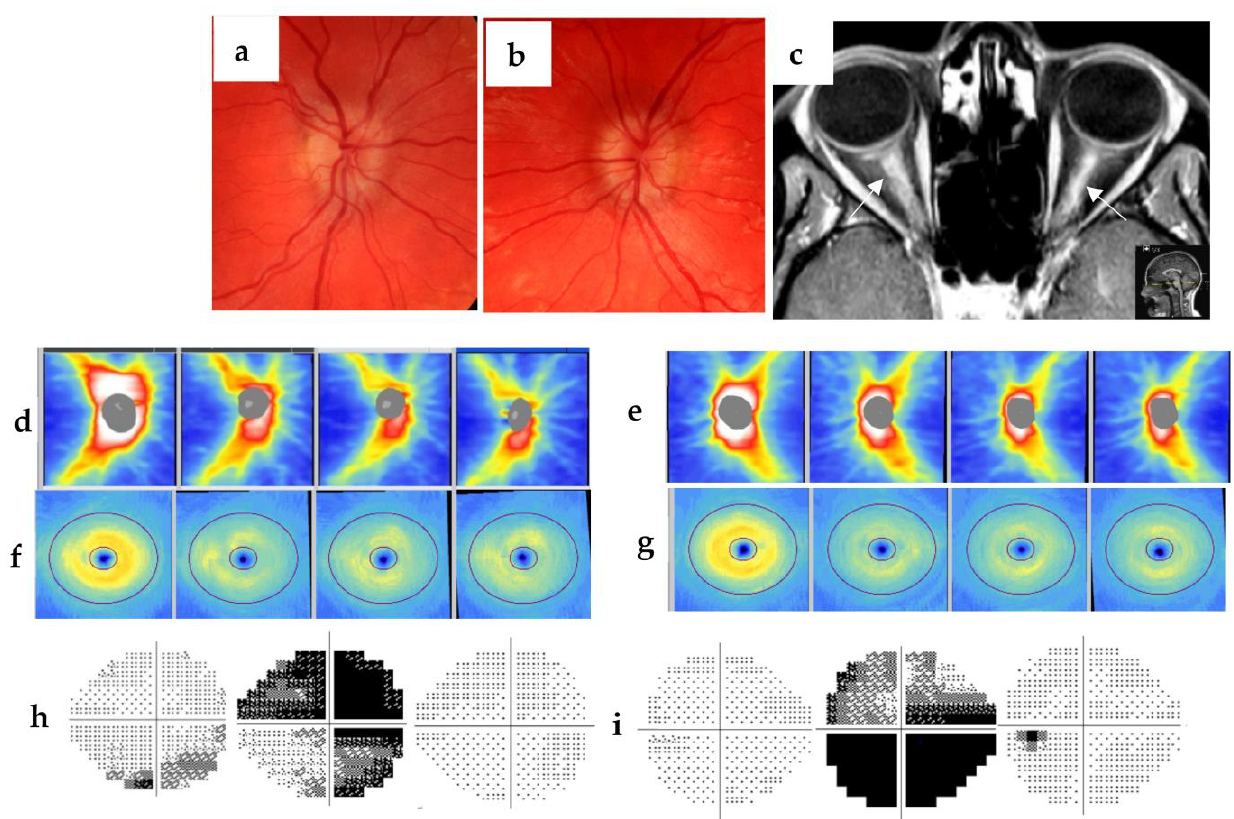
Figure 3. A 23-year-old obese female with positive myelin oligodendrocyte glycoprotein (MOG) antibody had bilateral subclinical ON demonstrated with MRI, OCT and VF. Fundoscopy showed papilledema in both right ( a ) and left eye ( b ). Orbital MRI visualized pathologic enhancement in the intraorbital optic nerves bilaterally ( c ). OCT thickness map showed significantly thickened RNFL in both right (152 µm) ( d ) and left (126 µm) ( e ) eyes at day 7, which was thinned at week 6 (right 100 µm, left 92 µm) and stable at follow-up of 3. 5 months and 3 years after onset. At day 7, GCIPL thickness was normal (right 74 µm, left 75 µm) ( f , g ), which was thinned at week 6 (right 66 µm, left 64 µm) and remained unchanged at 3. 5 months and 3 years. VF test ( h , i ) on day 7 demonstrated peripheral scotoma in the right (VFI 88%) and normal in the left eye (VFI 99%). VF was severely reduced in both eyes on day 14 (VFI right 26%, left 21%) but recovered at week 6 (VFI right 98%, left 94%).